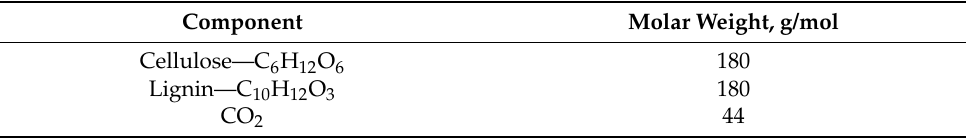
Table 2. Molar weight of components used in the calculation. Component Molar Weight,